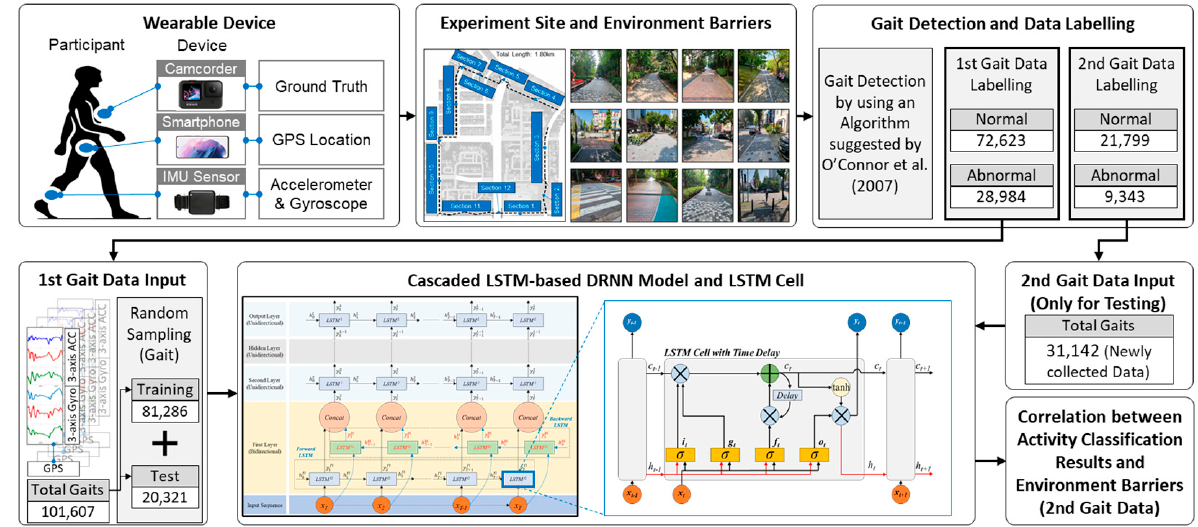
Figure 2. Research Framework.